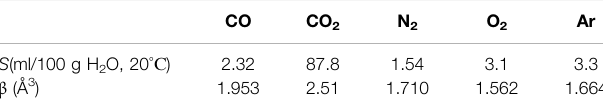
TABLE 2 | Solubility and polarizability of